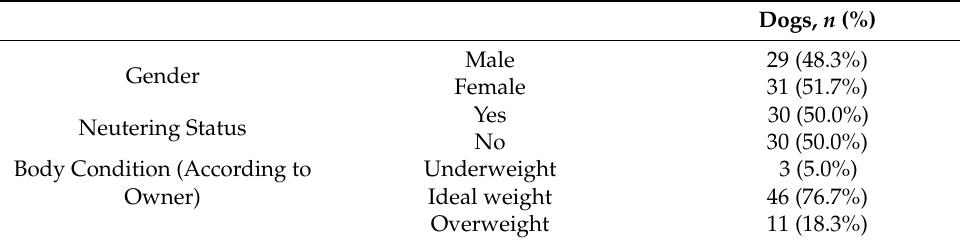
Table 4. Characteristics of dogs enrolled in this study ( n = 60).